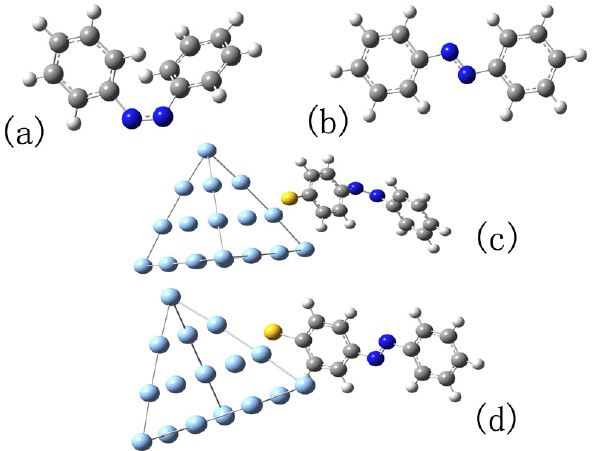
Figure 1. ( a , b ) The structures of cis and trans configurations of azobenzene molecule, respectively; ( c , d ) the structures of the complexes in model 2 formed by cis and trans with Ag cluster, respectively. All structures are optimized at B3LYP/6-31G